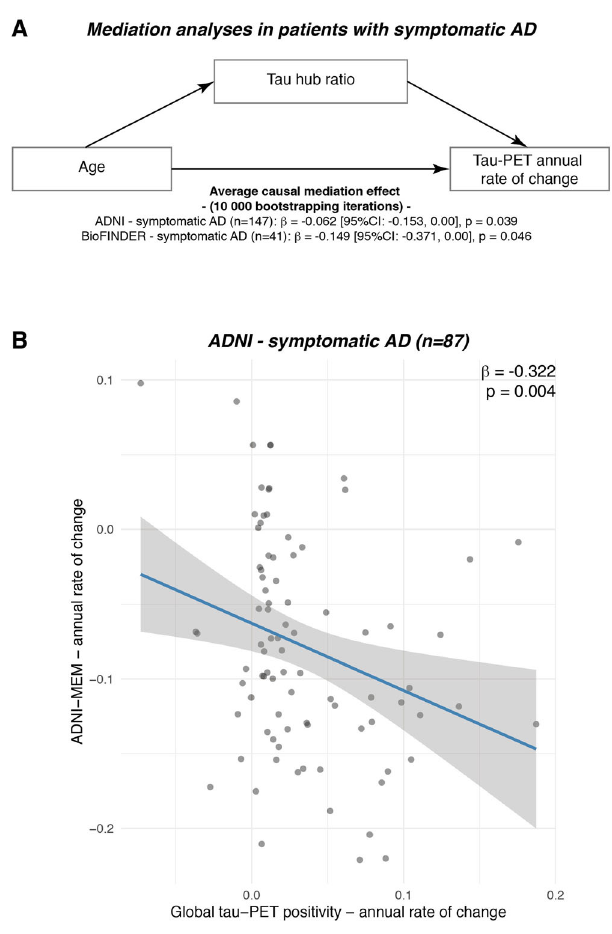
Fig. 5 | The association between younger age and faster tau accumulation is mediated by a higher tau hub ratio. A Mediation analysis in patients with symptomatic AD (ADNI: N =87, BioFINDER: N =25), showing that the association between younger age and faster annual tau accumulation rates is mediated by tau hub ratio. Mediation effects (i.e., β -values, 95% con fi dence intervals [CI] and uncorrected two-sided p values) were determined based on bootstrapping with 10,000 iterations, while all paths were controlled for age, sex and education. B In the ADNI symptomatic AD sample with available longitudinal cognition on a memory composite (i.e., ADNI-MEM, n =87), we plotted the association between tau-PET accumulation rates ( x -axis) and cognitive change rates ( y -axis). β -values re fl ect standardized regression weights. β -and two-sided p values were derived fromlinearregression,controllingforage,sexandeducation.Linearmodel fi ts(i.e., least squares line) are indicated together with 95% con fi dence intervals. Source data are provided as a Source Data fi